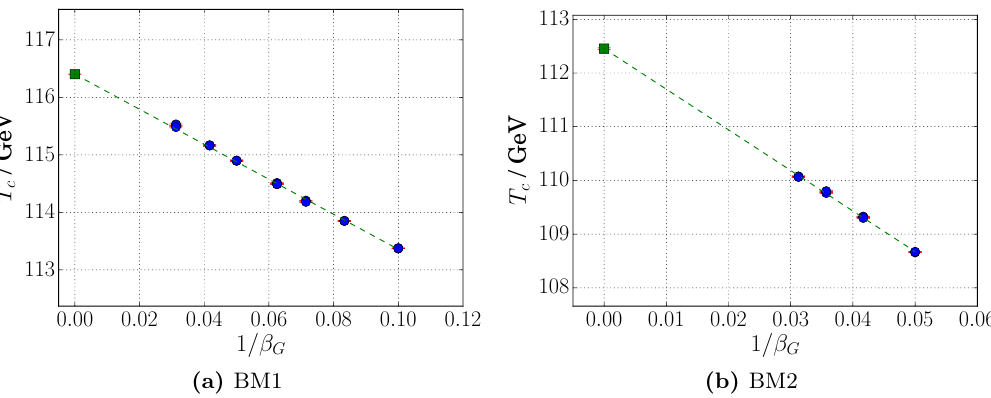
Figure 3. Continuum extrapolation of the critical temperature. All volumes are plotted here and are indistinguishable from each other at the same (cid:12) G